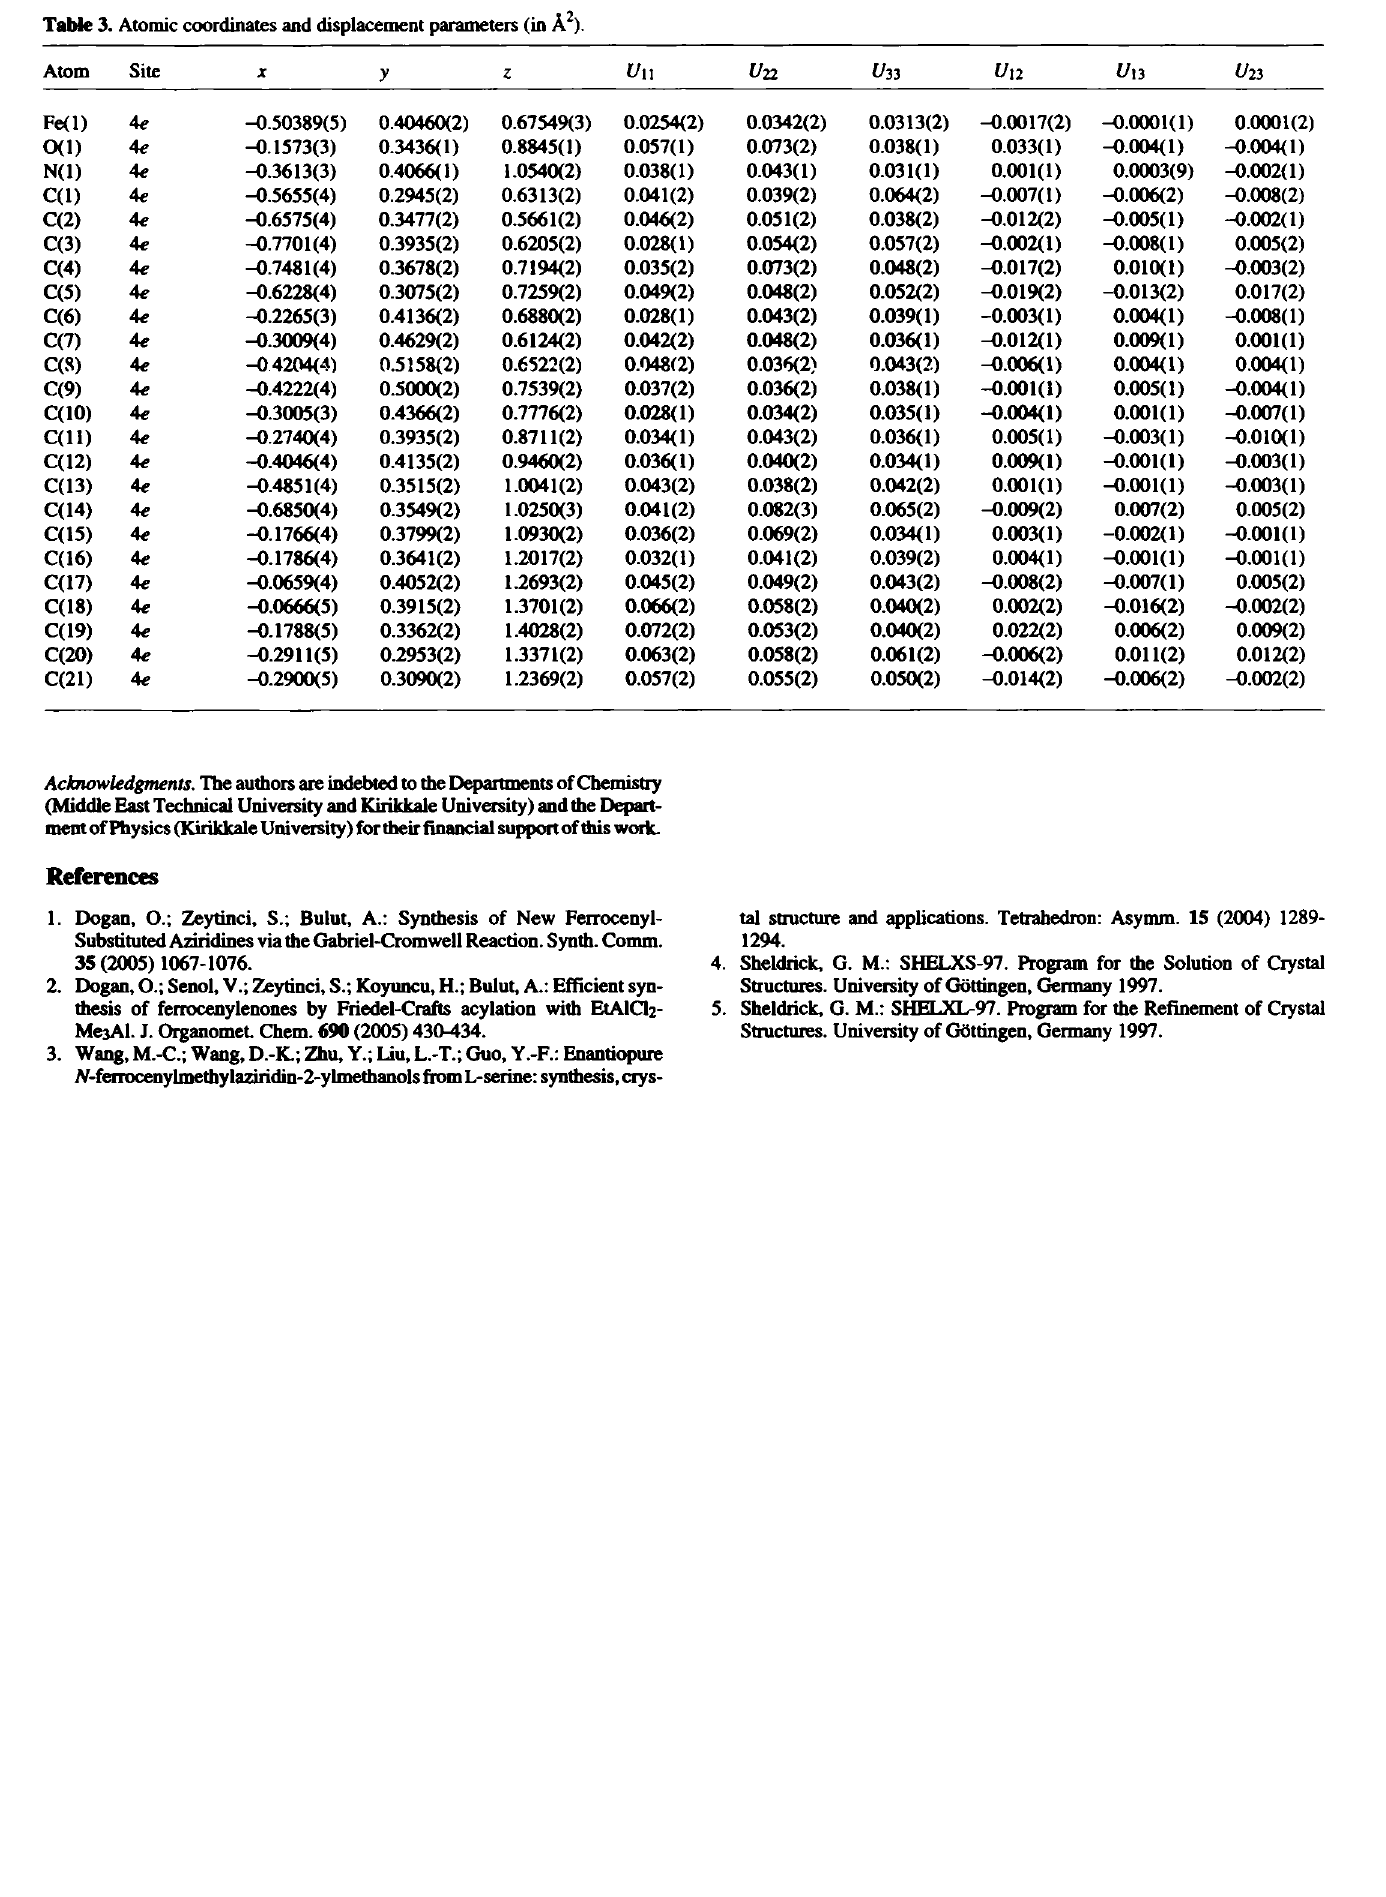
Table 3. Atomic coordinates and displacement parameters (in A 2